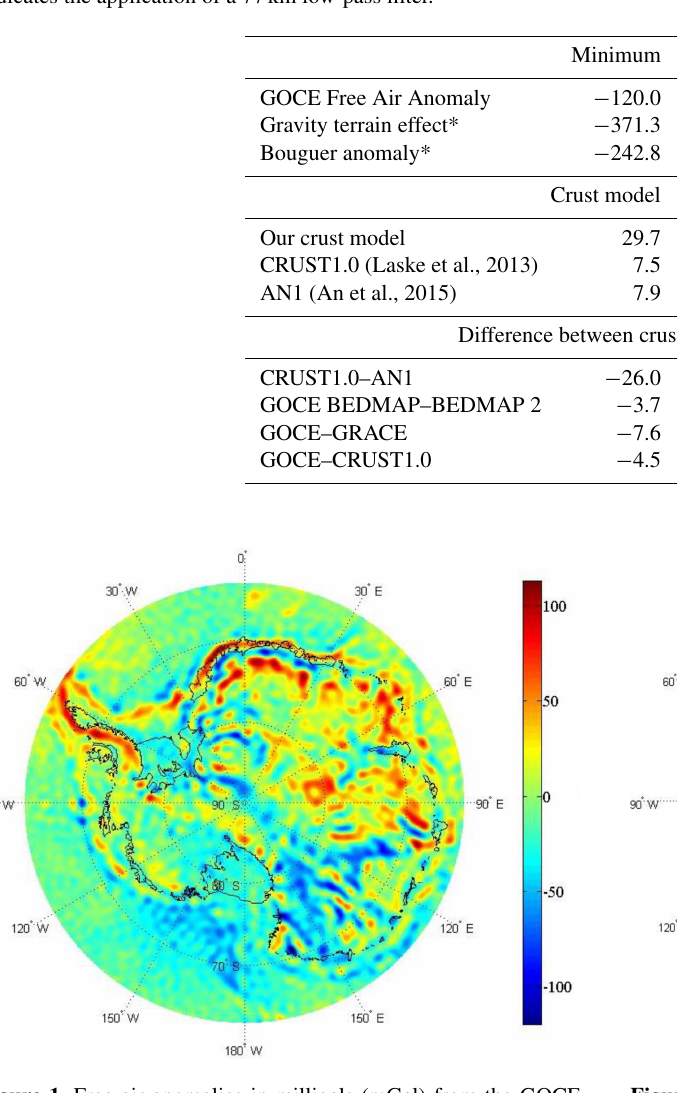
Figure 2. Difference between ice thickness from BEDMAP 2 and BEDMAP (max: 1628m, min: − 896m, mean: 19m). This differ- ence is filtered to the maximum spatial resolution of GOCE (77km) to represent the range of wavelengths that are significant in our